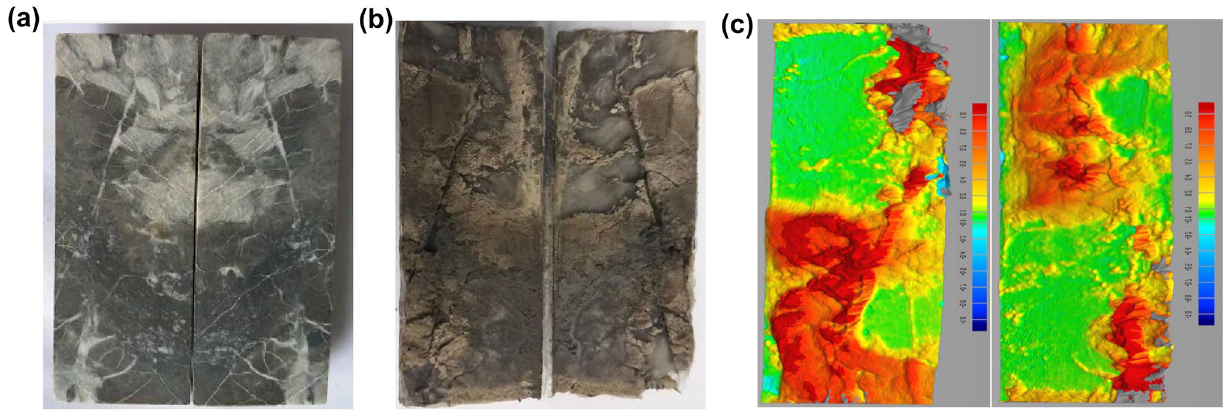
Fig. 8 Morphologies of gypsum-containing dolomite before ( a ) and after ( b ) corrosion with retarded acid and surface scanning image after cor- rosion ( c )